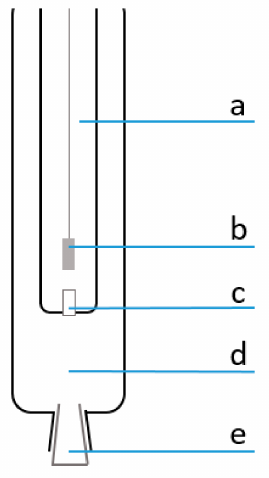
Figure 1. Schematic view of the double junction Ag/AgCl reference electrode (DJ RE): ( a ) inner compartment; ( b ) silver wire coated with silver chloride; ( c ) diaphragm separating the inner from the outer compartment; ( d ) outer compartment; ( e ) ground-joint sleeve junction separating the outer compartment from the test